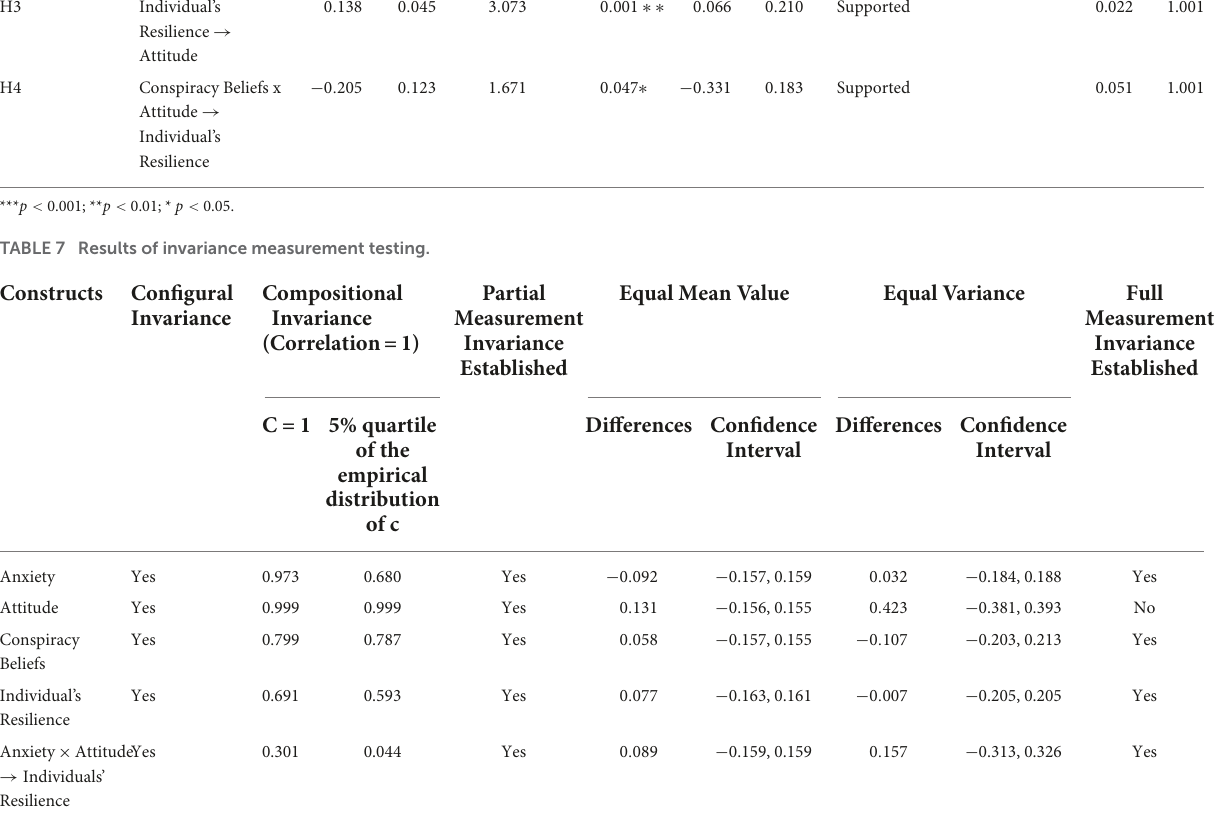
TABLE 6 Hypothesis testing.